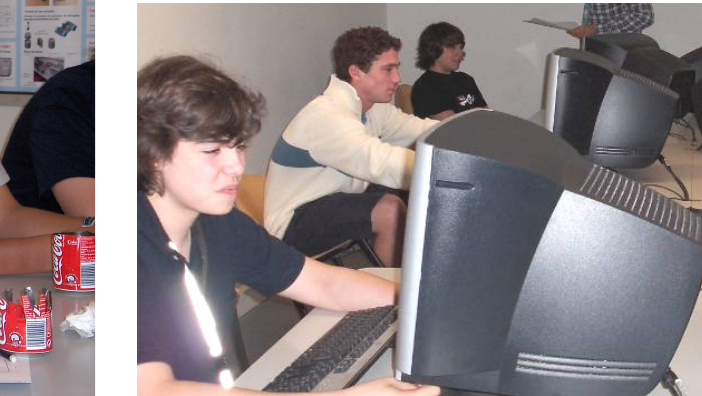
Figure 9. Management game